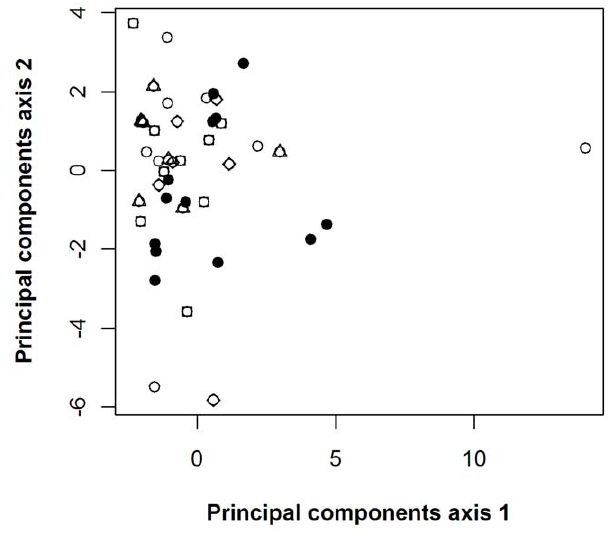
Figure 2. Plot of the first two principal components axis scores for each scorer. Here scorers are identified according to group: national policymakers=open circles, local/regional government ecolo- gists=closed circles, representatives of non-governmental conservation organisations=squares, academics=diamonds, farmers/farm advisers/ farm consultants=triangles. Analyses of variance of the first two principal components axis scores for each scorer showed no significant difference between different scoresheets (p=0.636 for axis 1; p=0.364 for axis 2) or between the five scorer groups (p=0.085 for axis 1, p=0.705 for axis 2). A single scorer in the national policymaker group scored differently from others, giving relatively high scores for the interventions in the ‘ Ex situ conservation’ category. With this single scorer removed from the analysis, the p value in the analysis of axis 1 scores by scorer group was